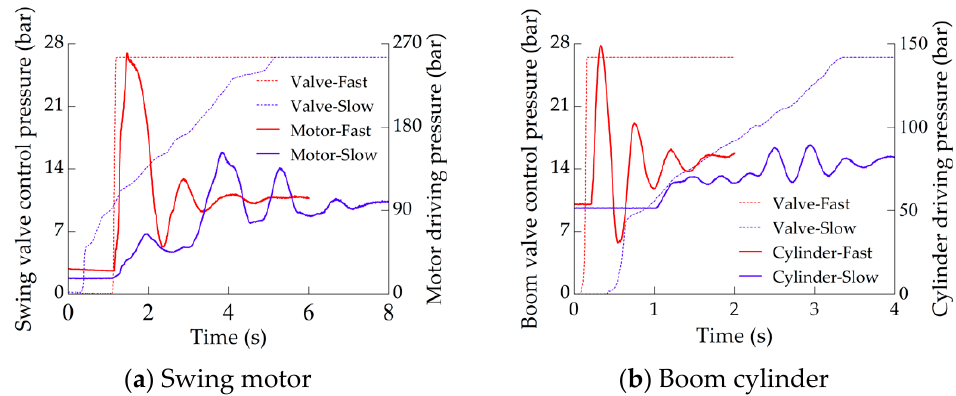
Figure 4. Driving pressure characteristics of swing motor and boom